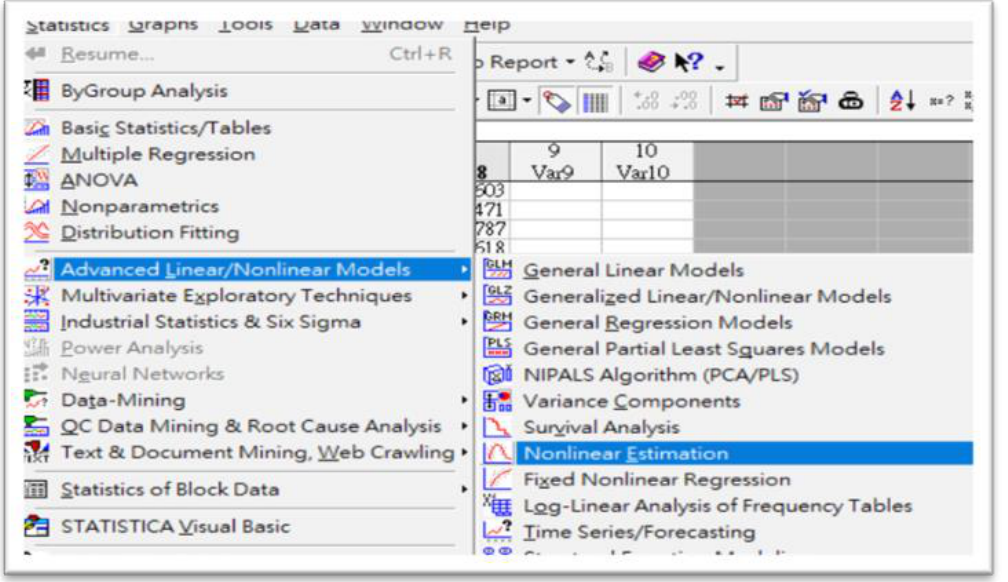
Figure 3. A typical STATISTICA 7.0 program in function. The user must follow the suggested options and define the unique loss function to obtain the coefficient matrix according to the IPA technique.